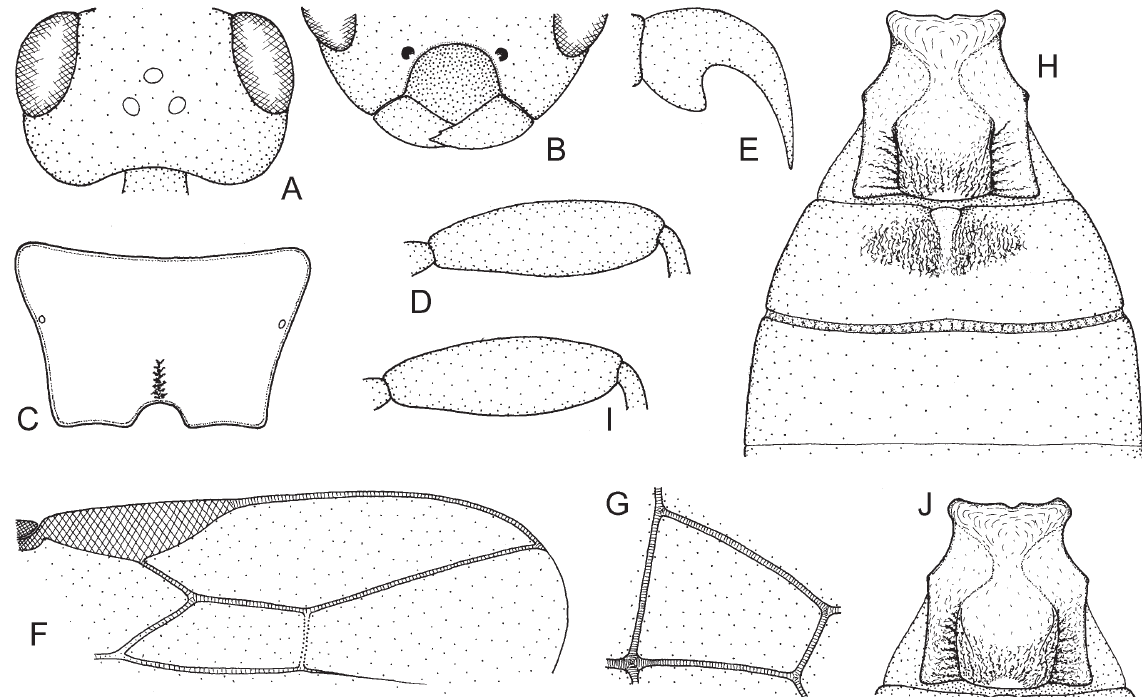
Fig. 28. Bracon ( Glabrobracon ) nigriventris Wesmael, 1838 (A-H: ♀ holotype, I: ♀, J: ♂). A . Head in dorsal view. B . Head in frontal view. C . Propodeum. D . Hind femur. E . Claw. F . Distal part of right forewing. G . First discal cell of right forewing. H . Tergites 1-3. I . Hind femur. J . First